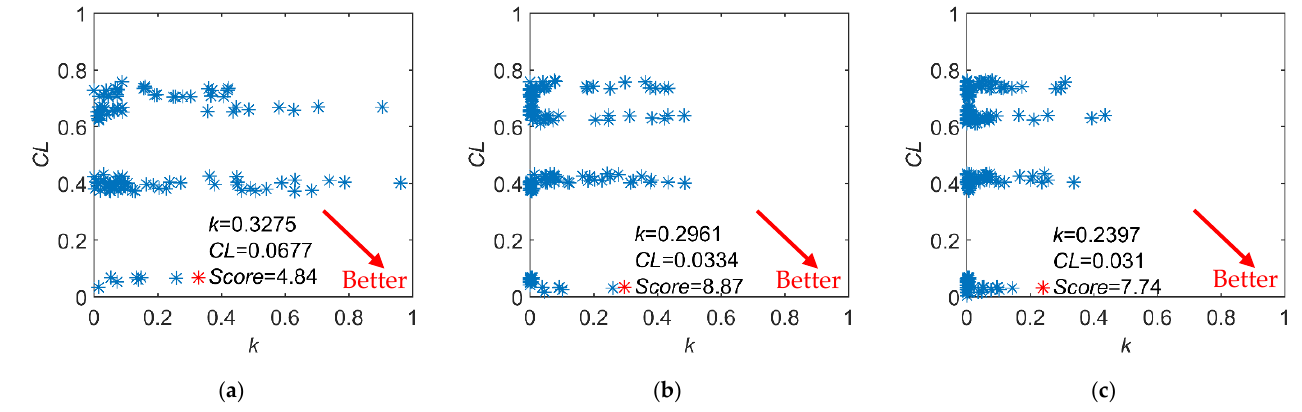
Figure 9. The evaluation results of traversing different number of indices: ( a ), ( b ), ( c ) are the results of p = 3, 4, 5, respectively, k is the independence coefficient, and CL is the comprehensive loss rate of the contribution rate. ( a ) p = 3. ( b ) p = 4. ( c ) p = 5. Table 3. Comparison results of different index sets.